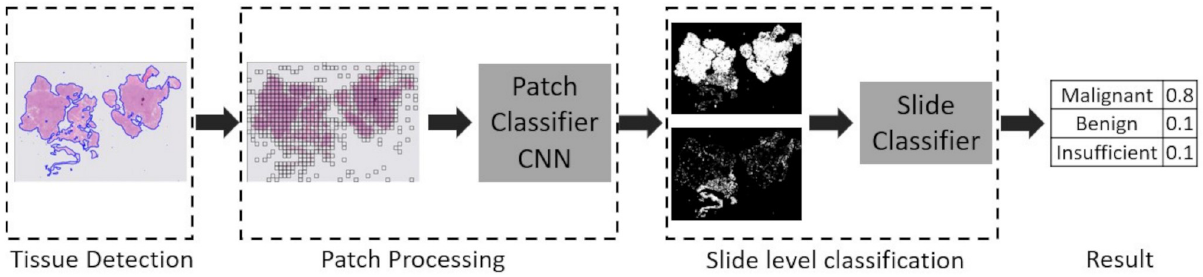
Fig 3. Complete processing pipeline for complete endometrial biopsy